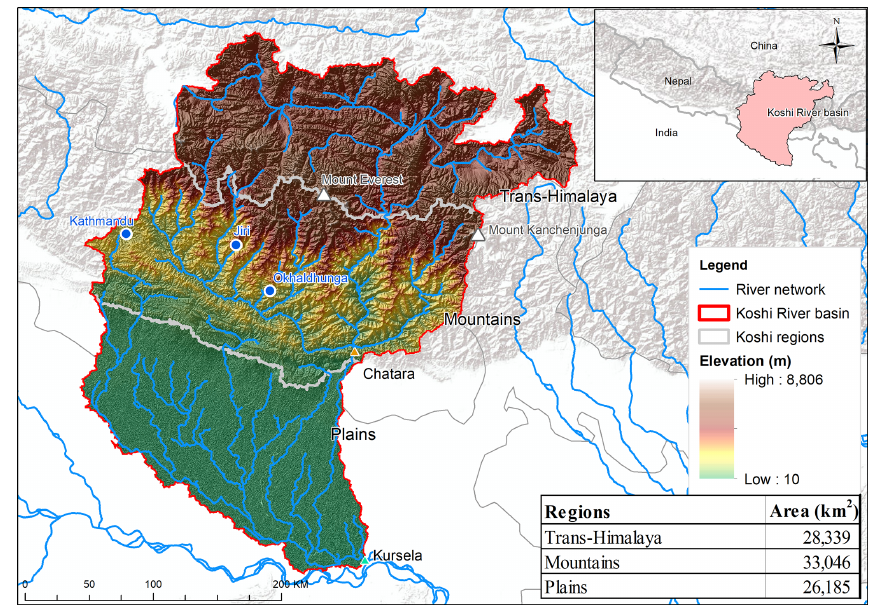
Figure 1. The transboundary Koshi River basin straddling the trans-Himalaya, the mountains, and the plains. Note: the map has used a Shuttle Radar Topography Mission (SRTM) 90m digital elevation model (DEM) that publicly available at http://srtm.csi.cgiar.org/ (last access: 1 June 2020) and Esri background terrain map, available with ArcMap 10.6.1